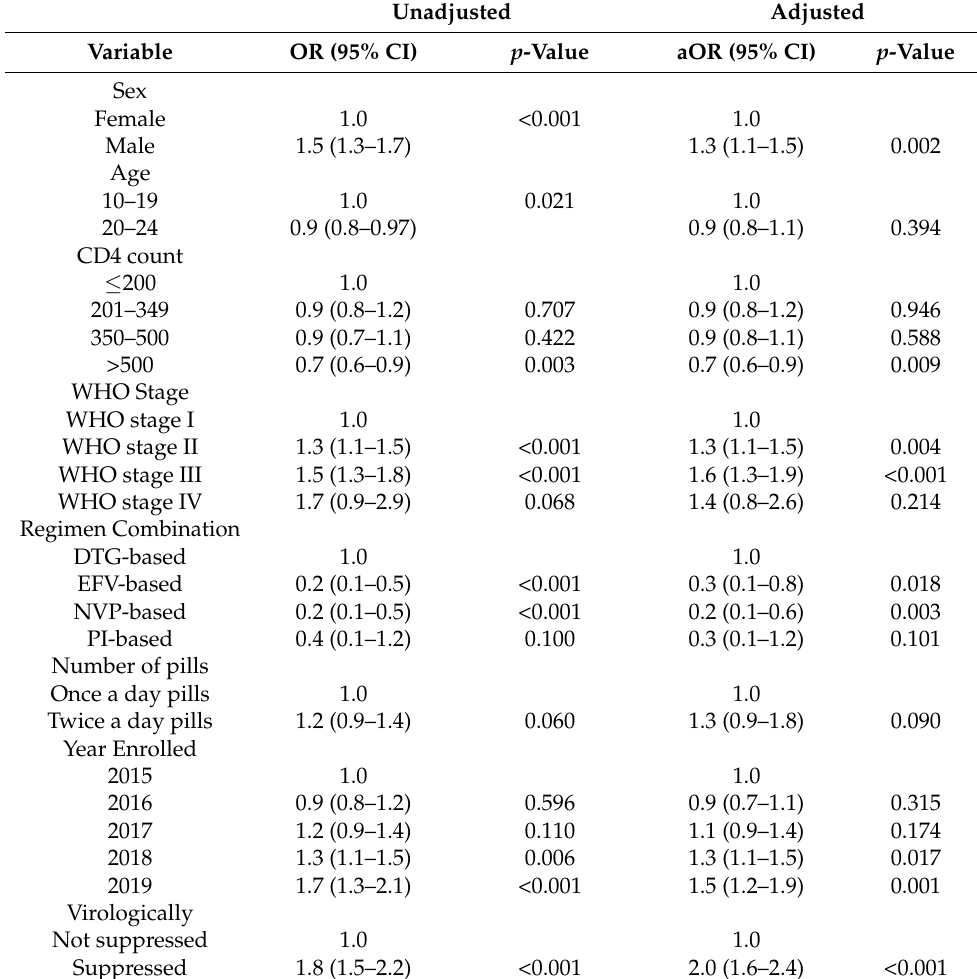
Table 2. Factors associated with a good ( ≥ 85%) medication possession ratio ( n = 5750). Unadjusted Adjusted Variable OR (95% CI) p -Value aOR (95% CI) p